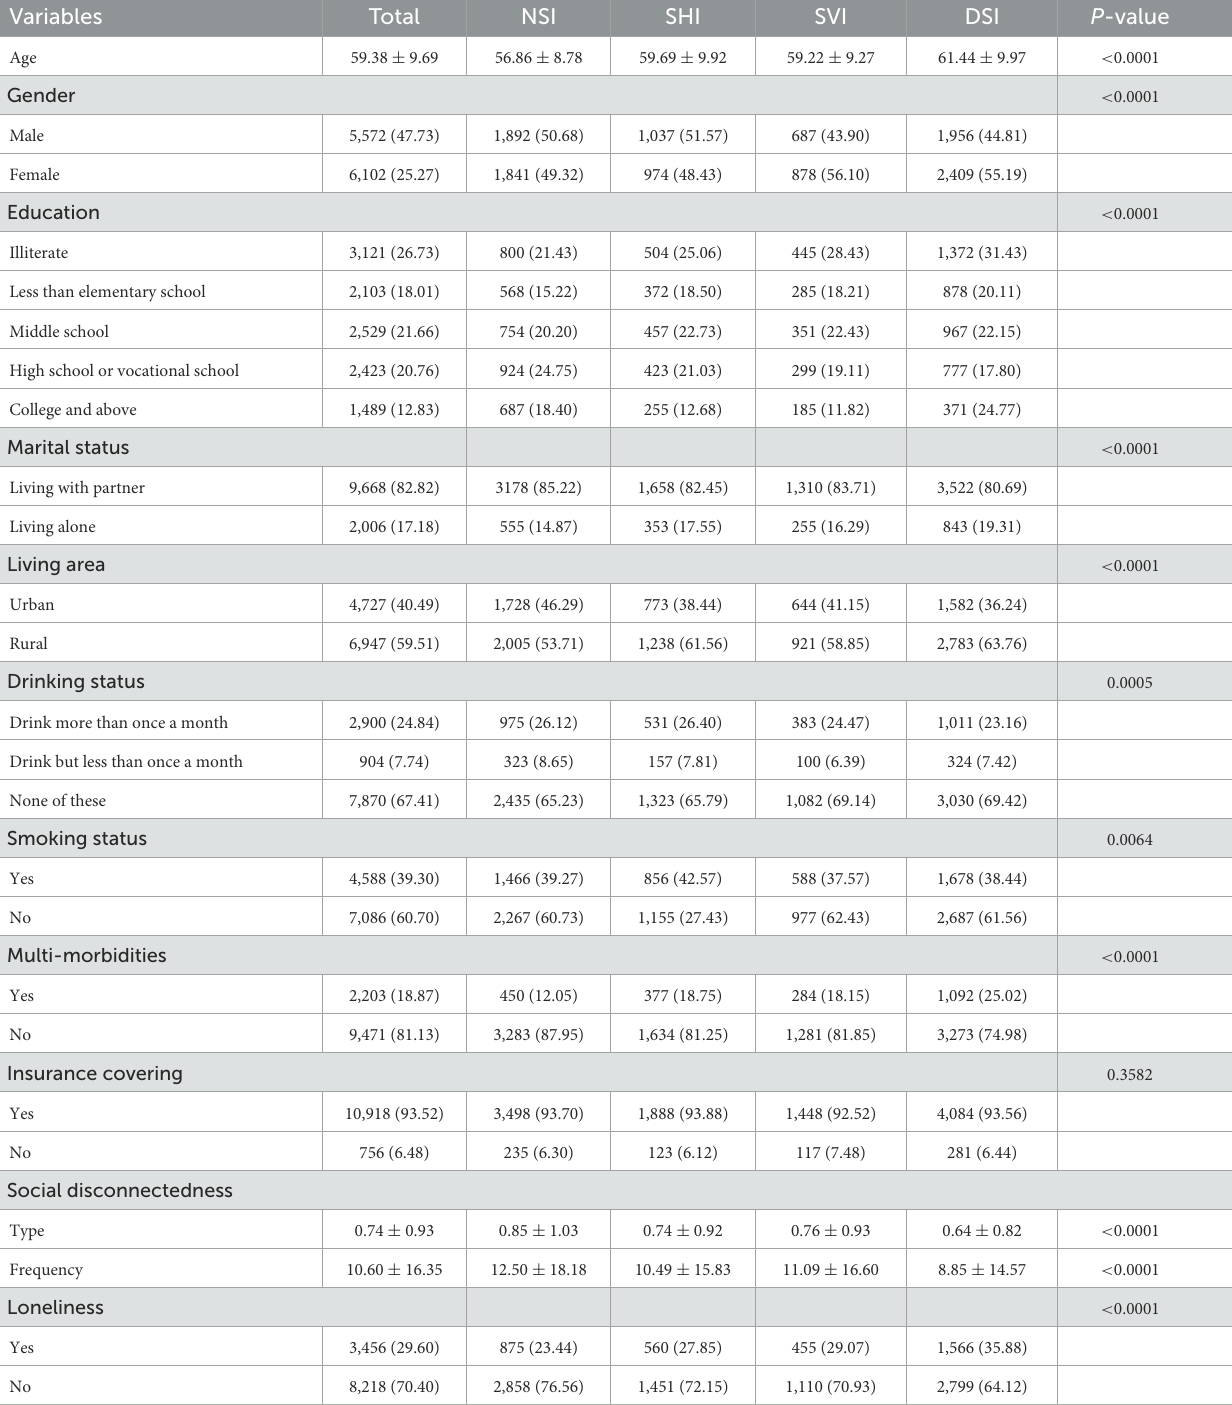
TABLE 1 Characteristics of participants in the present study from CHARLS